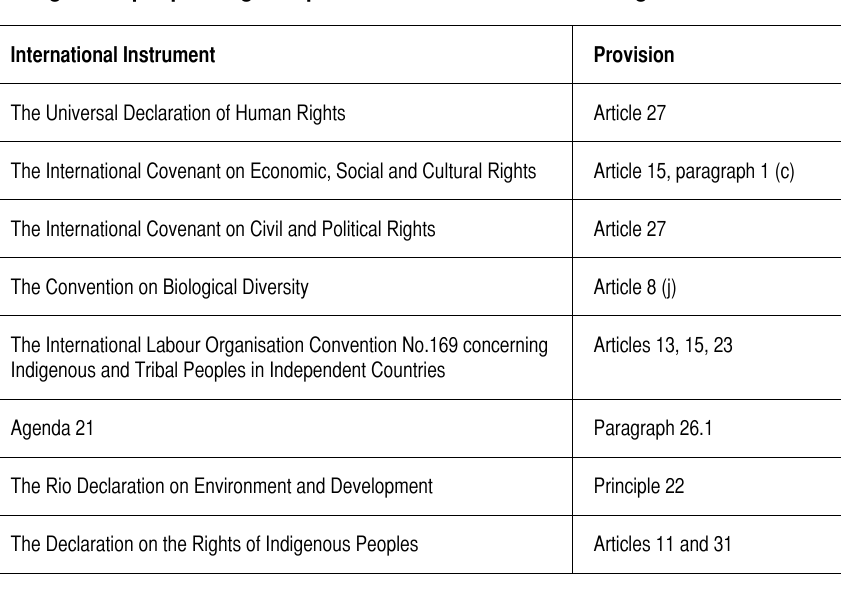
Table 1: Summary of major international instruments that recognise Indigenous peoples’ right to protect their traditional